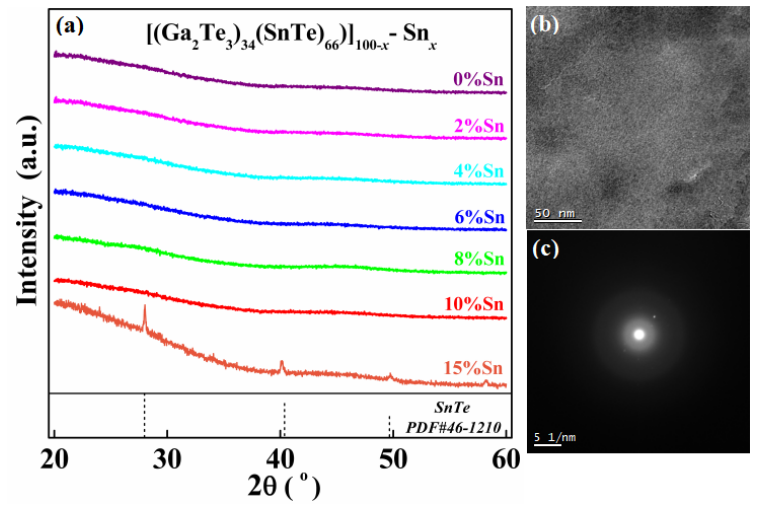
Figure 1. ( a ) XRD patterns of the melt-spun [(Ga 2 Te 3 ) 34 (SnTe) 66 ] 100-x -Sn x samples ( x = 0, 2, 4, 6, 8, 10 and 15%), the TEM image ( b ) and corresponding SAED pattern ( c ) for S8